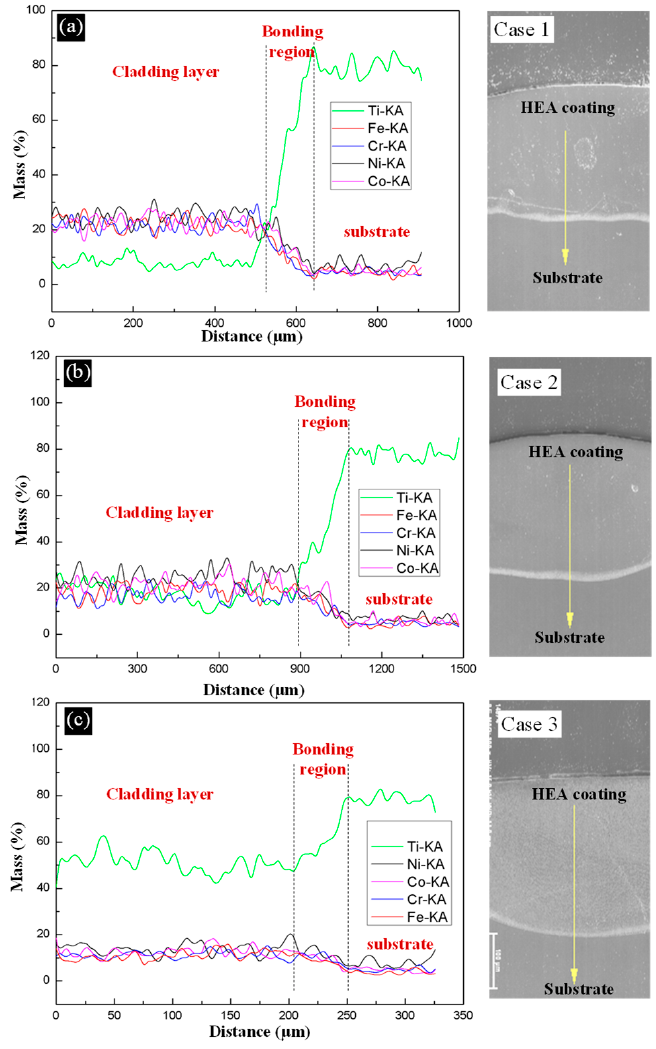
Figure 8. ( a ) EDS line scanning of Case 1, ( b ) EDS line scanning of Case 2, ( c ) EDS line scanning of